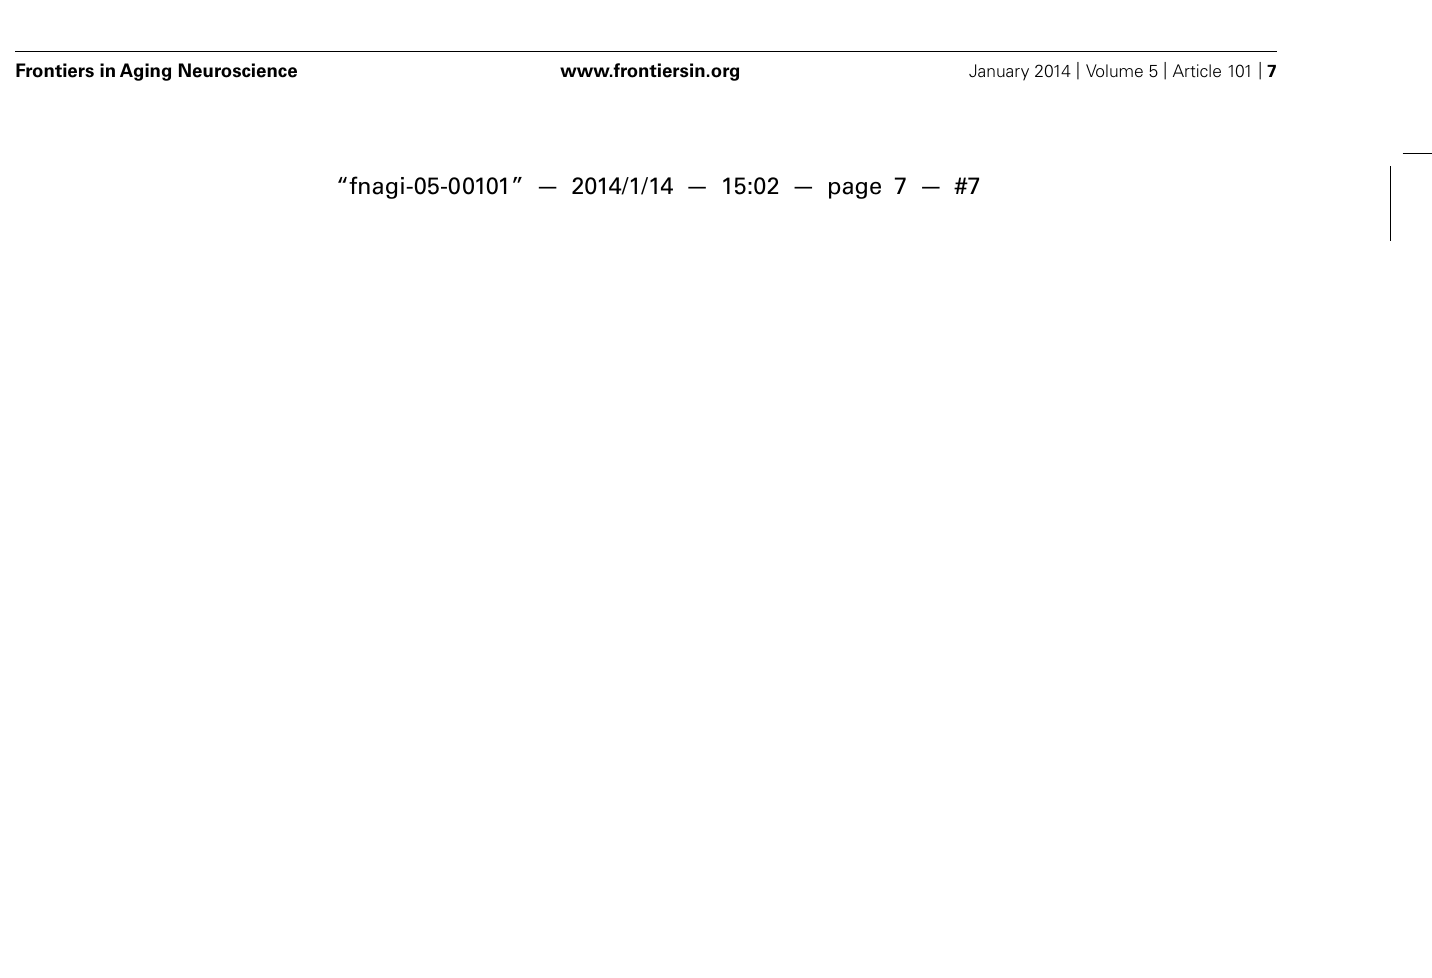
Table 5 | Comparison of visual saliency in three image regions (0–20 ◦ , 20–40 ◦ , 40–60 ◦ ) with the entire image as well as the comparison of the upper image halves with the lower image halves (expressed as saliency quotient). Saliency